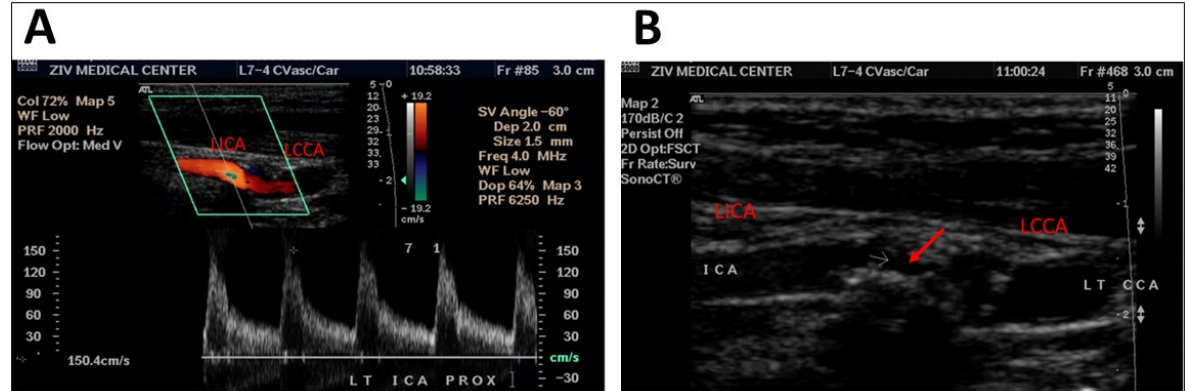
Figure 1. DUS scan of a patient showing moderate stenosis of 50–70%, as seen by an increase in the flow velocity of the left internal carotid artery ( A ) and by occlusion site ( B , red arrow). LICA = left internal carotid artery, LCCA = left common carotid artery, ICA = internal carotid artery, LT = left, CCA = common carorid artery.